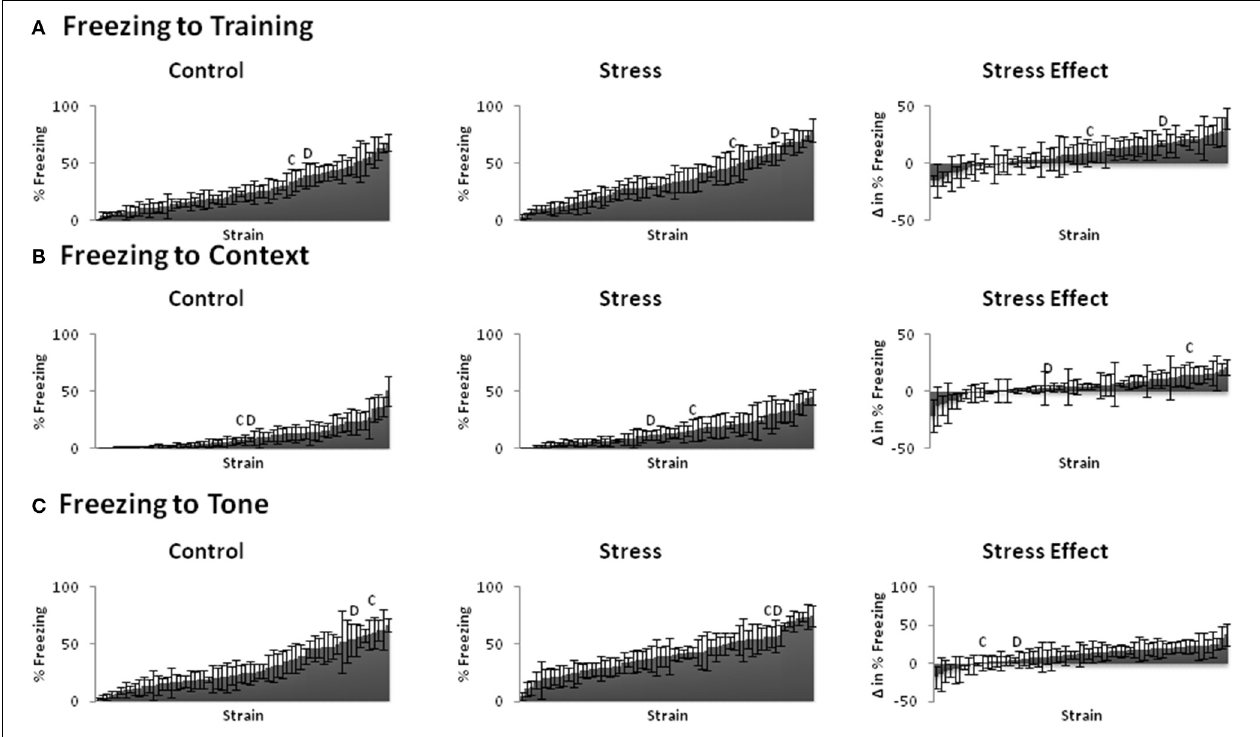
FIGURE 2 | Behavioral phenotypes of fear conditioning paradigm. Mean ± s.e.m. % time freezing for Control (Left) and Stress (Middle) populations, and mean ± s.e.m. difference in % freezing between littermates (Stress